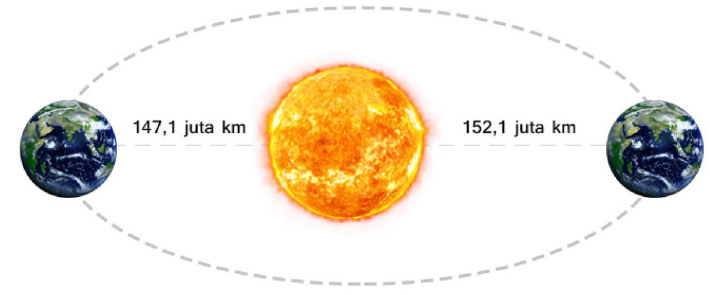
Figure 8. The elliptical trajectory of the planet